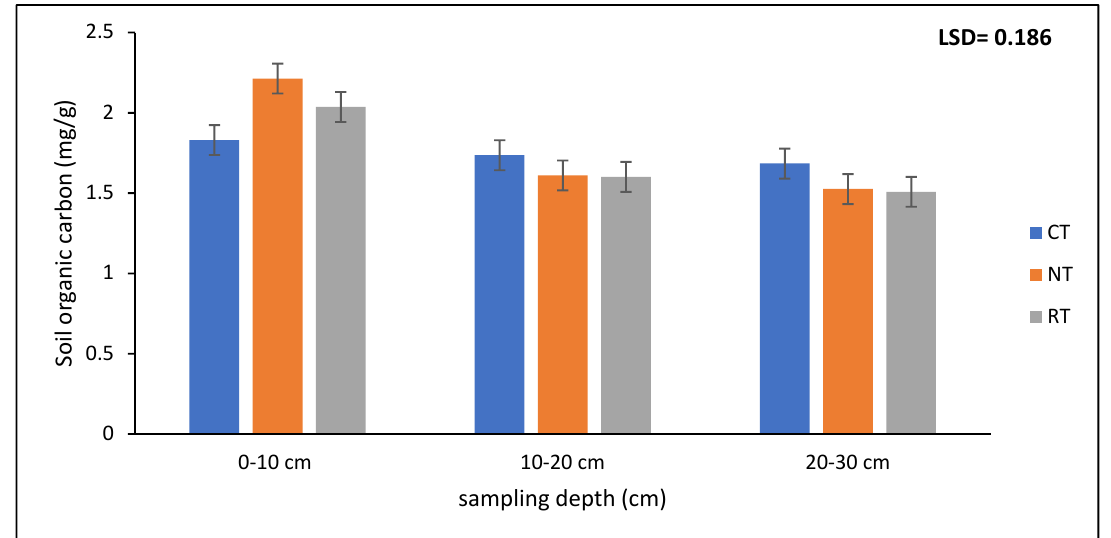
Figure 6. Soil organic carbon (SOC) at three different N fertilizer levels (0, 100, 200 kg/ha) after 17 years of trial establishment. CT = conventional tillage, RT = rotational tillage, NT = no-till.